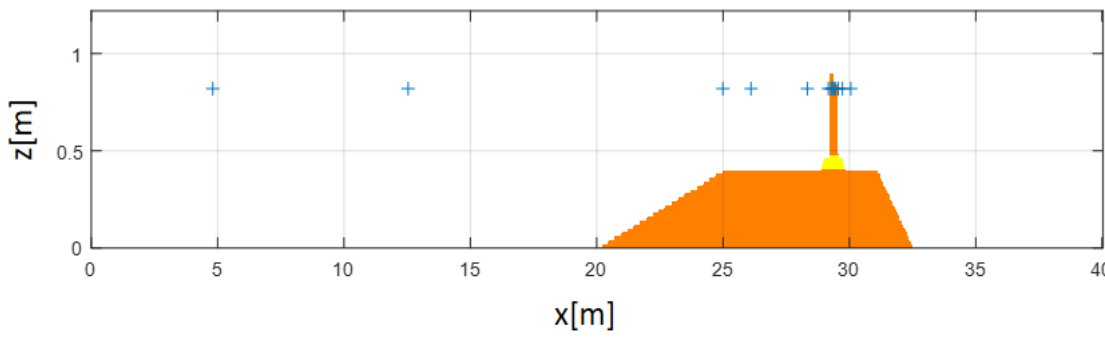
Figure 4. Sketch of the numerical model. “+” express the position of wave gauges.